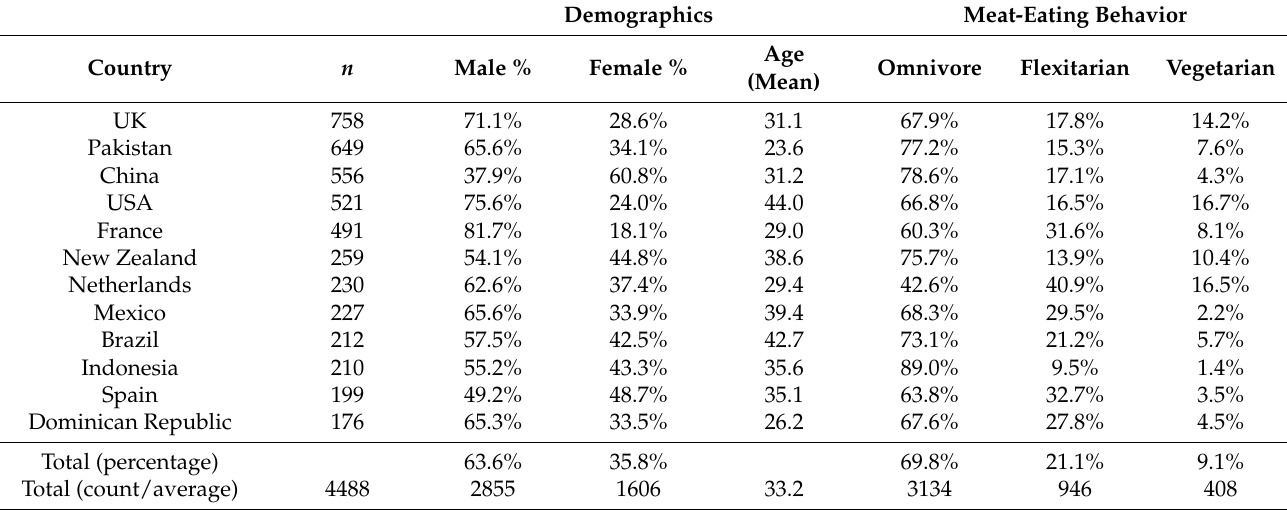
Table 1. Demographic Information ( n = 4888).